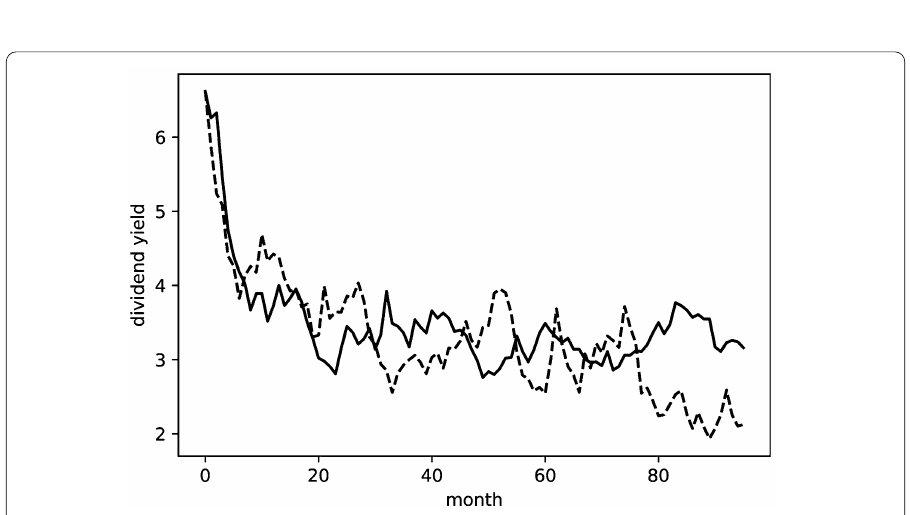
Figure 3 Sample of SEY model simulated path (dashed line) compared to actual data (normal